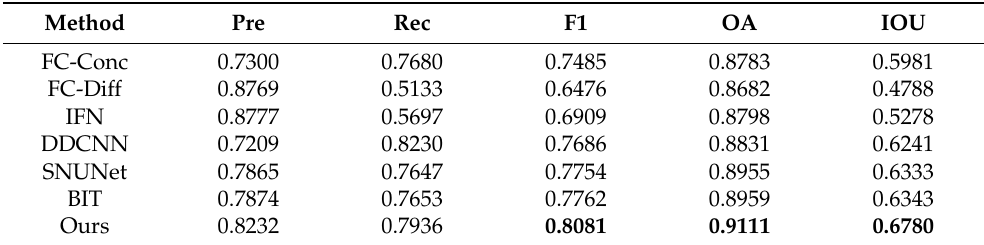
Table 2. The comparison results on the SYSU dataset.